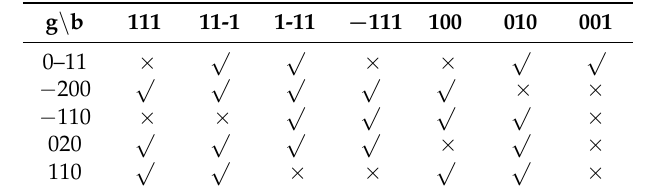
Table 1. The invisibility criteria for dislocation loops in TEM observation.